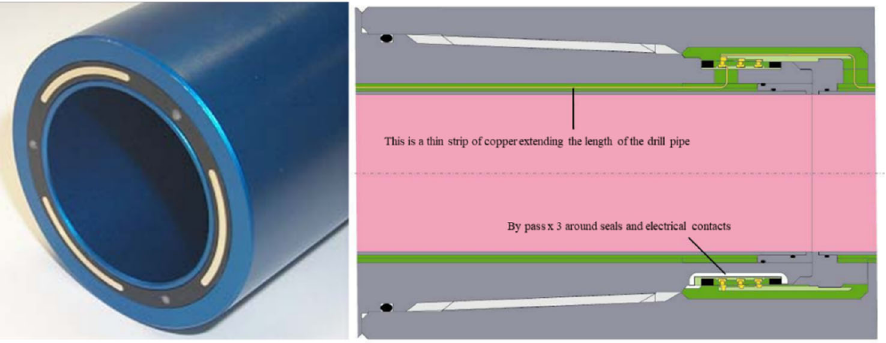
Figure 5. Structure diagram of the wire butt method.